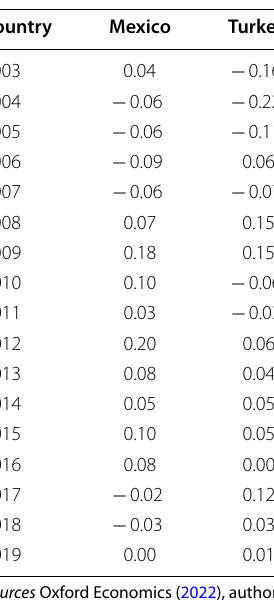
Sources Oxford Economics (2022), author’s calculations